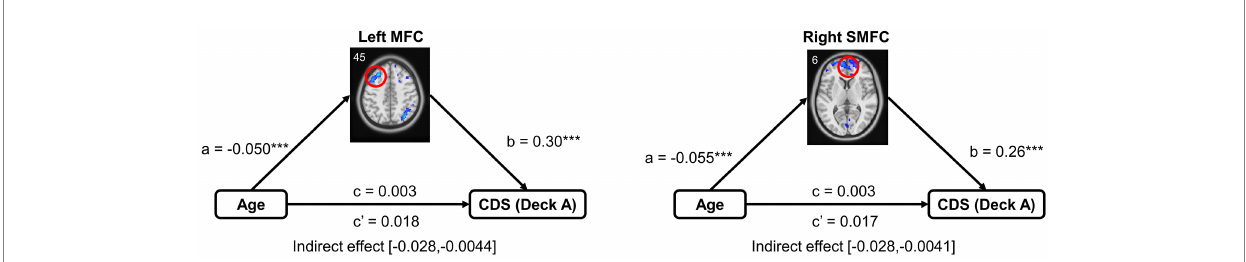
FIGURE 5 Mediation analysis in the relationship between age and task performance. Mediation analysis showed that brain activation of the frontal subregions (the left MFC and right SMFC) mediated the relationship between age and CDS in high punishment frequency, controlled for MoCA, GM, and head motion. MFC, middle frontal cortex; SMFC, superior medial frontal cortex. *** p <